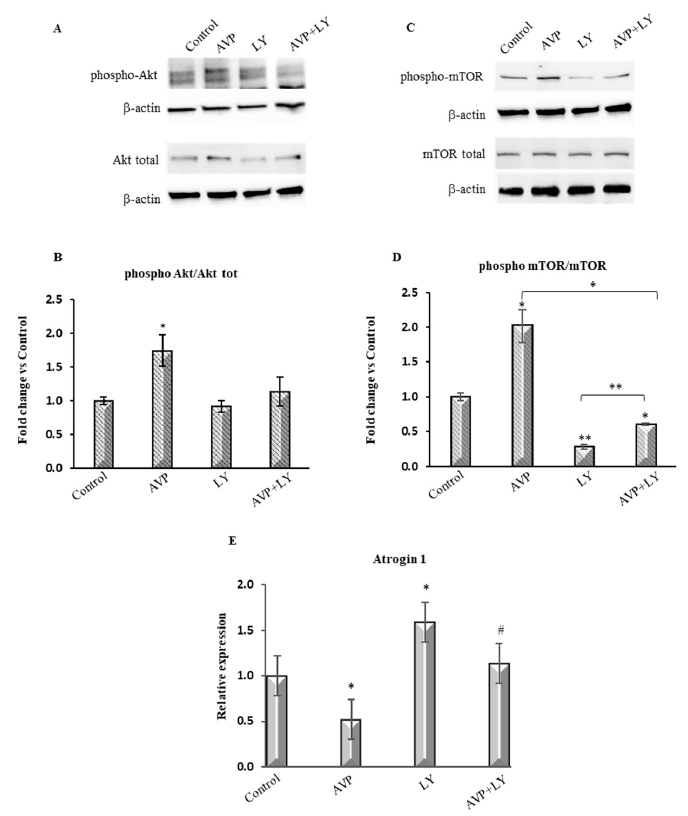
Figure 2. LY294002 inhibits the AVP-dependent stimulation of PI3K / Akt / mTOR pathway. L6 cells